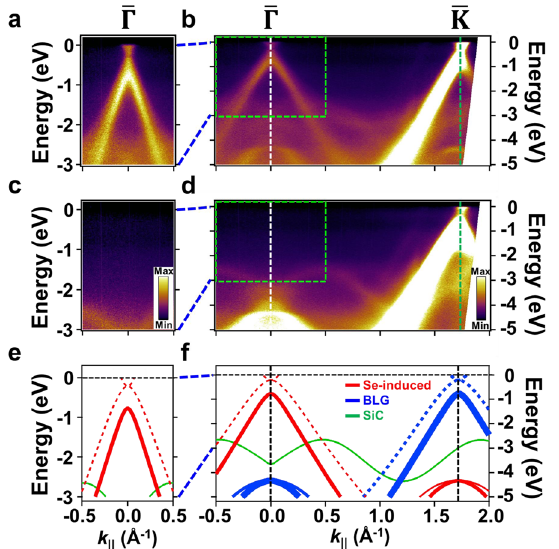
Fig. 1 Band structure measurements. a ARPES map of Se-covered BLG near the zone center taken at 20 K, showing a cloned Dirac cone. b Same ARPES map with an adjusted intensity scale over extended energy and momentum ranges. c , d ARPES maps from the same sample warmed up to 30 K, indicating the absence of the cloned Dirac cone. e , f Band structure for the Se-covered BLG with the band origins